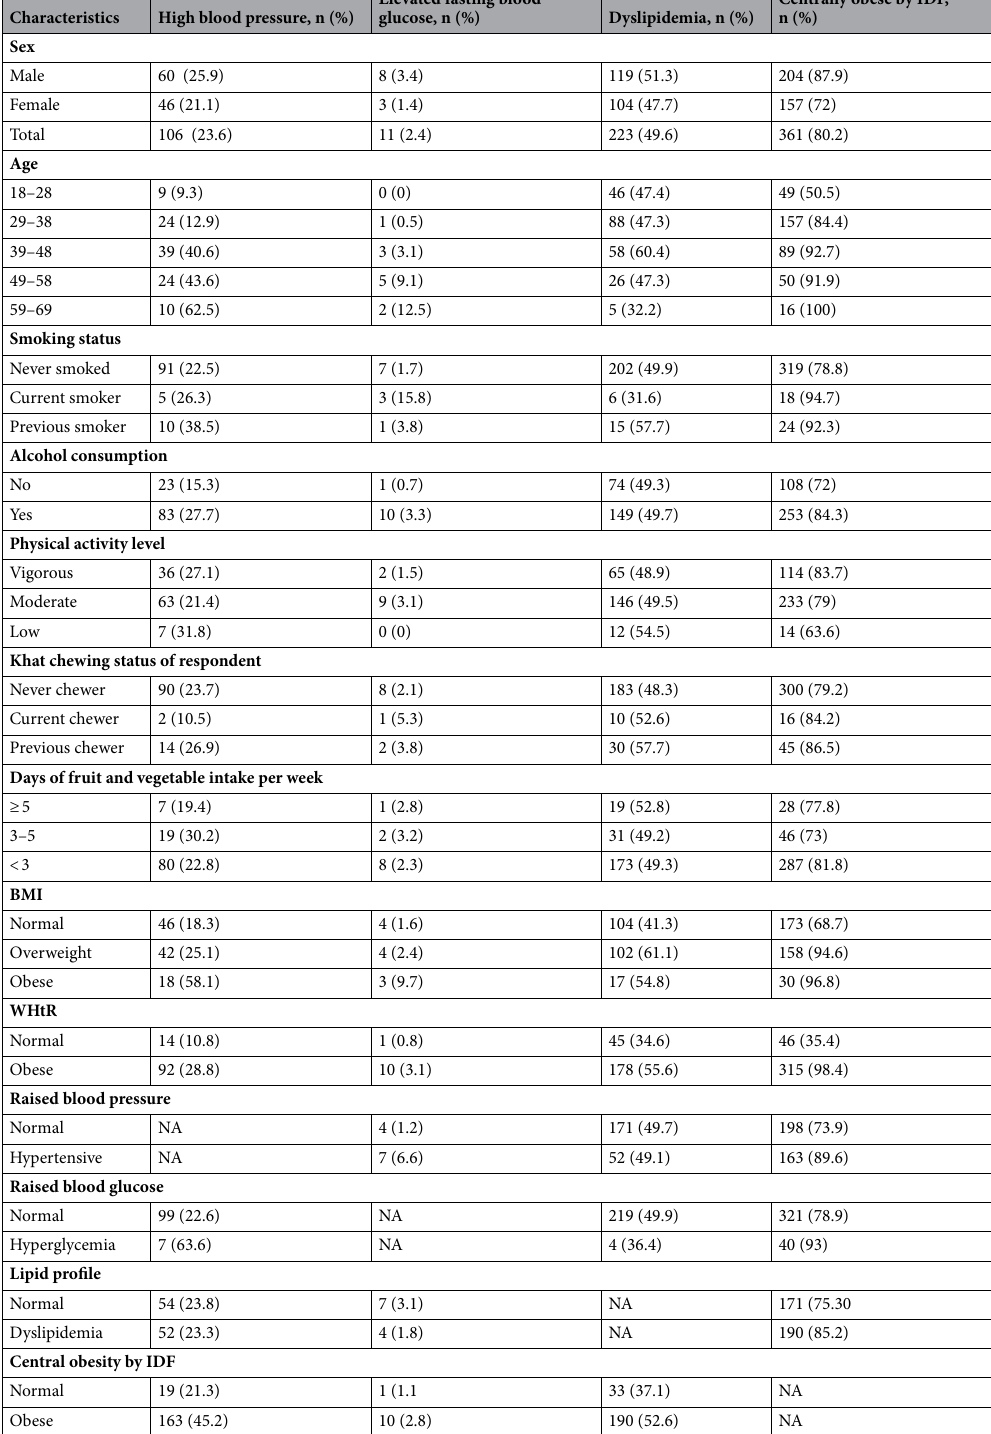
Table 4. Prevalence of blood pressure, blood glucose, lipid profiles abnormalities and central obesity of study participants at EPHI, Addis Ababa, Ethiopia, 2018 (n = 450). HTN hypertension, raised blood pressure (systolic raised triglyceride level ≥ 150 mg/dl and reduced HDL < 40 mg/dl in men and < 50 mg/dl in women). WHtR waist to height ratio (0.5 = normal and ≥ 0.5 obese), BMI body mass